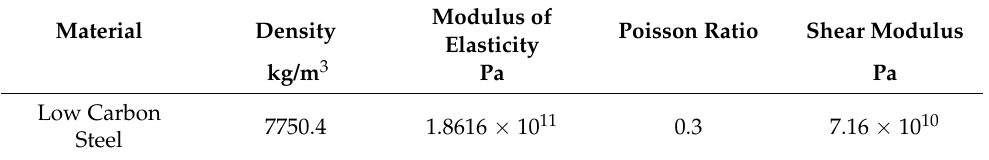
Table 2. Mechanical Properties of Steel.